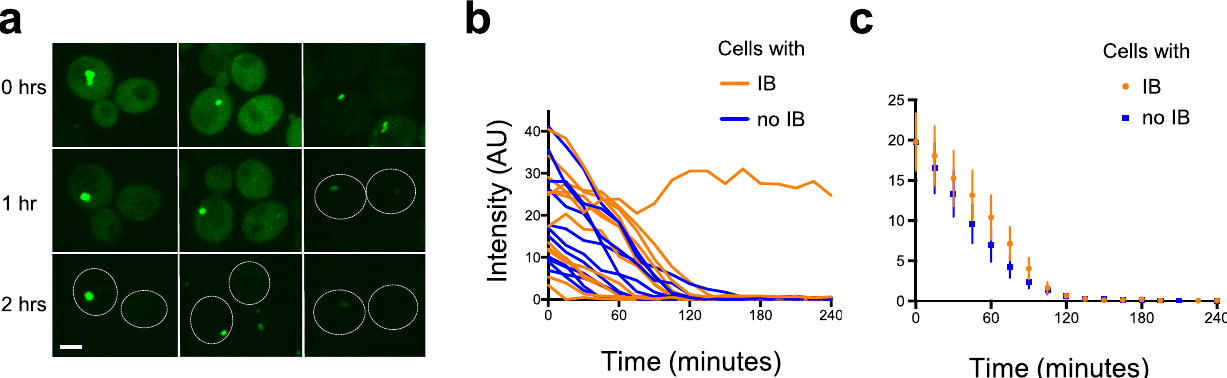
Fig. 7 The proteasome has a similar capacity to acutely degrade cytoplasmic mHtt-GFP in cells with and without inclusion bodies. a Time-lapse images of cells expressing mHttex1-degron-GFP were acquired every 15 min for 4 h after the addition of auxin. Maximum-intensity projection of three pairs of cells with similar cytoplasmic levels is shown; in the cell shown in the upper left image, the inclusion body (IB) was moving while the z-series was taken. Numbers indicate elapsed time. A confocal and bright fi eld image of the same fi eld of cells is shown in Supplementary Fig. 9. Scale bar, 2 μ m. b The cytoplasmic intensity of a random selection of cells with initial cytoplasm intensities between 5 – 45 AU with or without IBs, showing the loss of cytoplasmic mHttex1-degron-GFP after the addition of auxin at time 0. c The average cytoplasmic intensities of the cells shown in b , omitting the outlier. Error bars represent SEM; n = 11 for each category. Pairwise t -tests for each timepoint, without assuming a consistent SD and using the method of Benjamini, Krieger, and Yekutieli to correct for the false discovery rate, found no signi fi cant